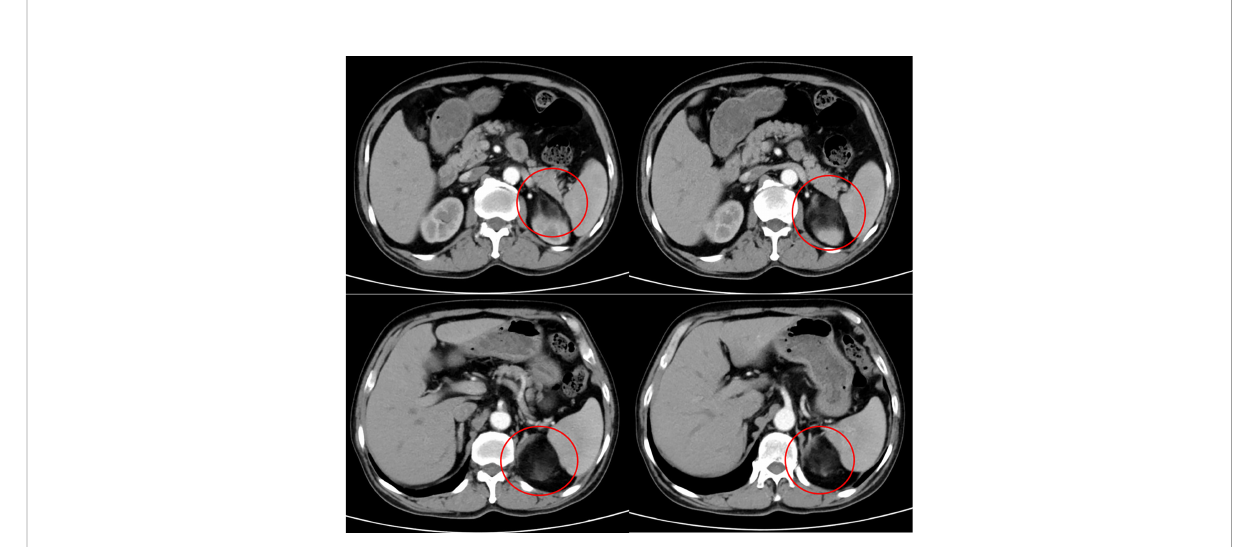
FIGURE 1 Abdominal computed tomography imaging, representing a left adrenal mass of